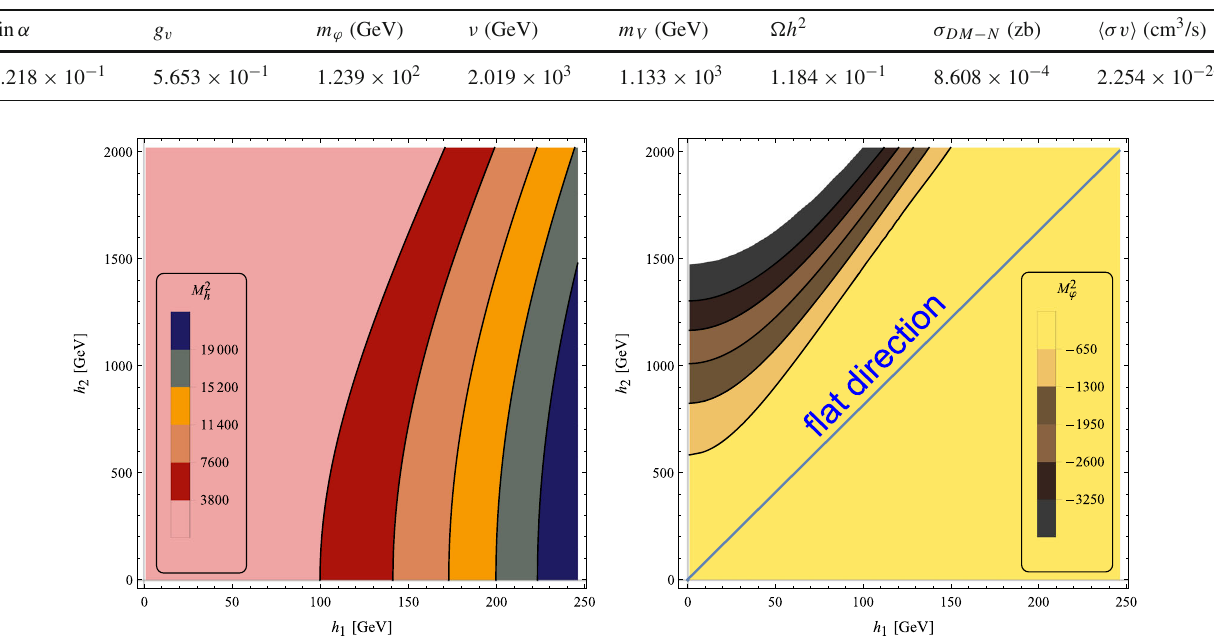
Table 1 A benchmark point of the model and corresponding DM relic density, SI DM-nucleon cross section, and DM total annihilation cross section. For this benchmark point, DM-nucleon cross section is below the neutrino-floor limit